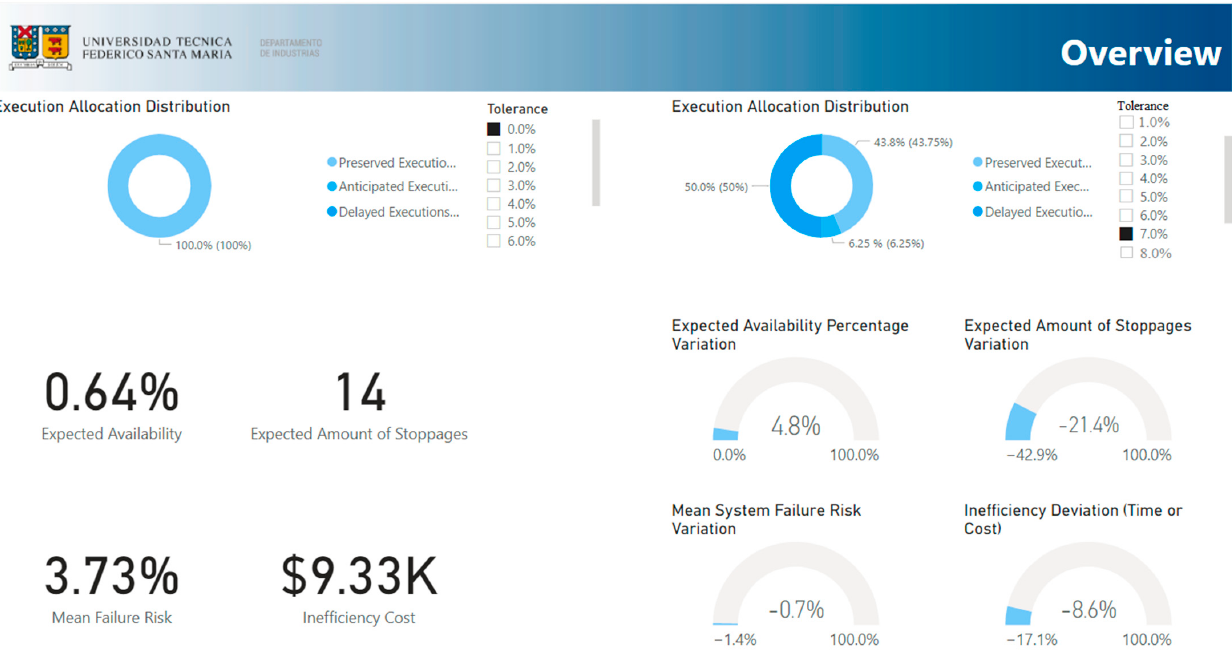
Figure 2. Overview Figure 2. Overview section.